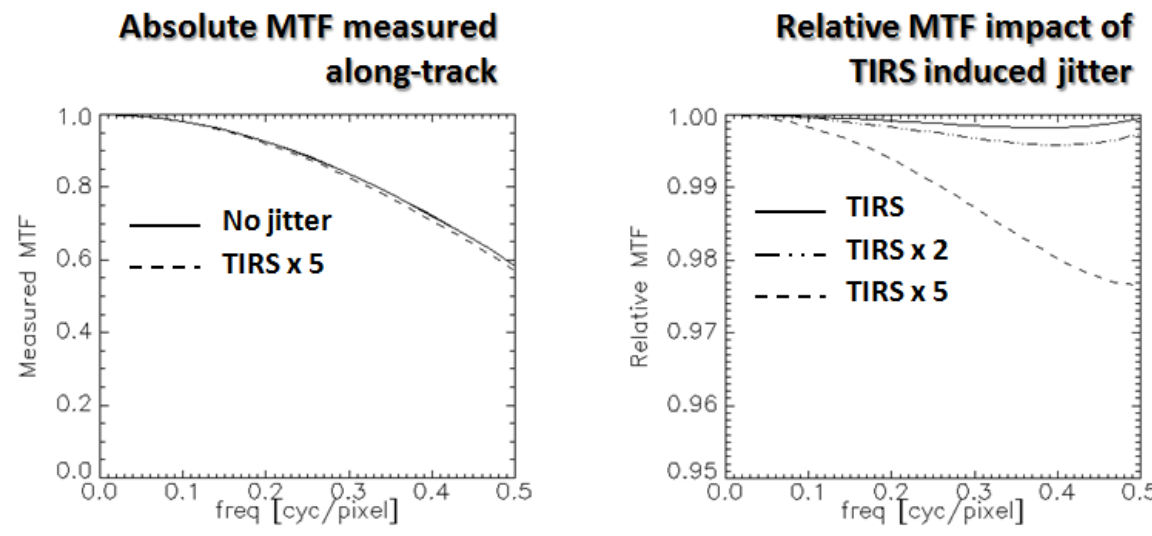
Figure 8. MTF calculated from “bridge” edges in the OLI simulated scenes for the ‘no jitter’ and the ‘TIRS jitter × 5’ case ( left ). The jitter impact is more clearly seen in the relative ( i.e. , ratio to no jitter) plots ( right